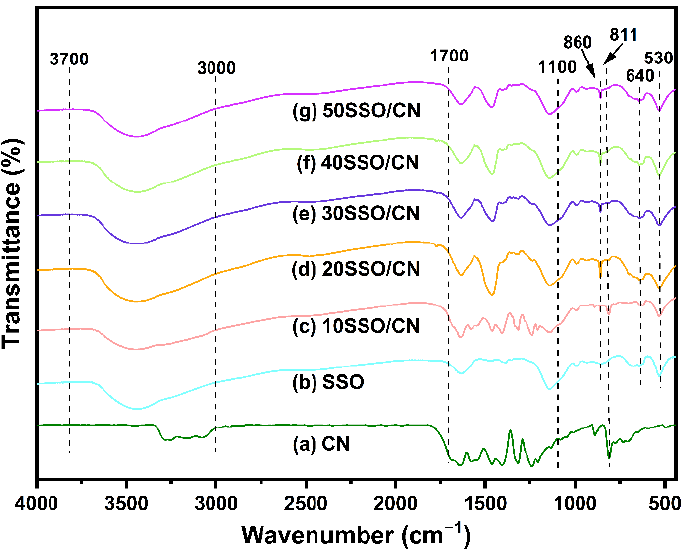
Figure 2. FTIR patterns of CN (a), SSO (b), 10SSO/CN (c), 20SSO/CN (d), 30SSO/CN (e), 40SSO/CN (f), 50SSO/CN (g).